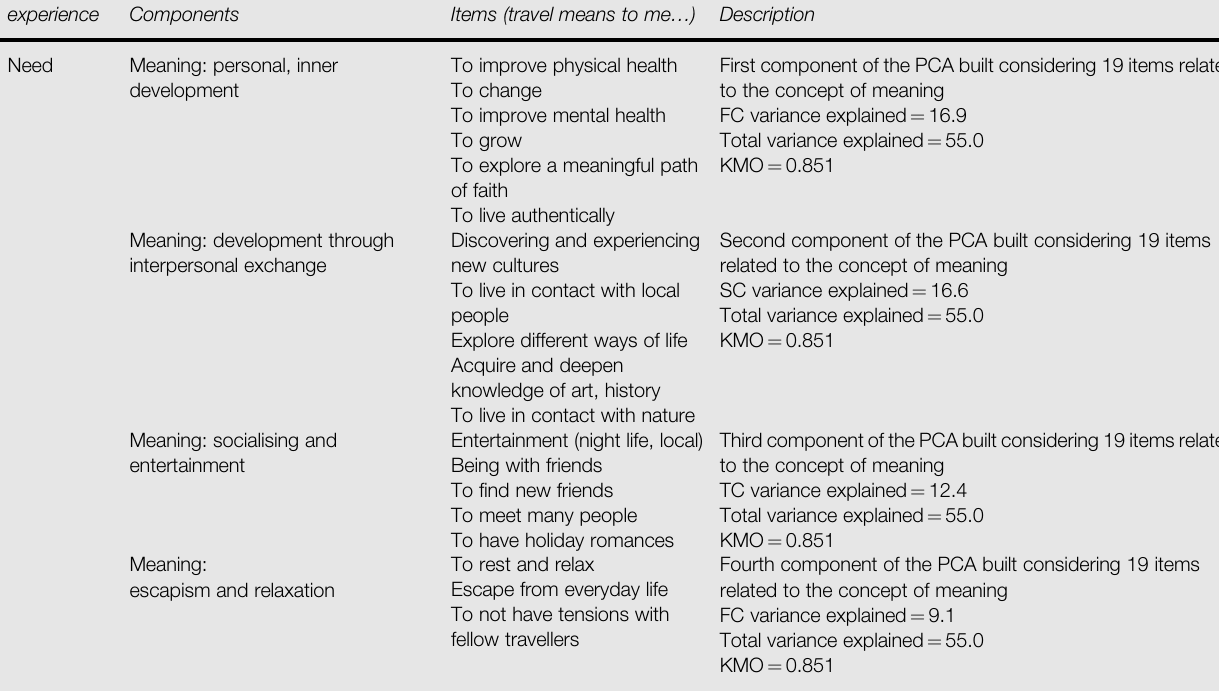
Table III Tourism experience – need component (meaning) processed from sampled data Tourism experience